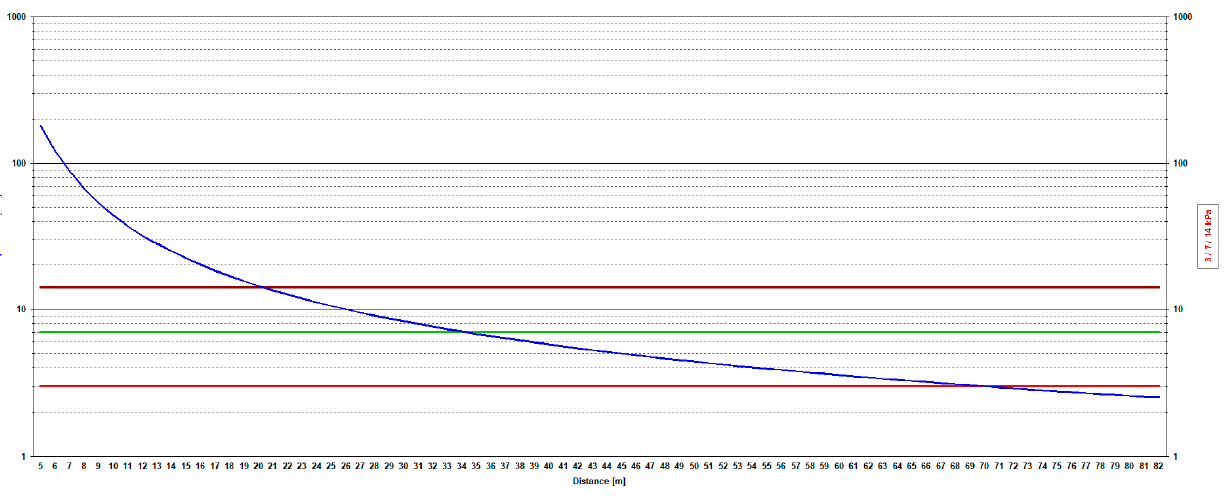
Figure 8. Information about shock wave